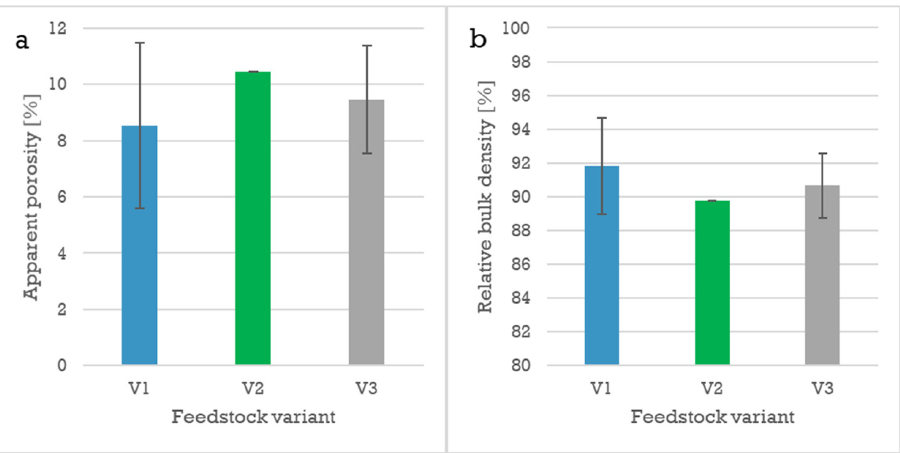
Figure 10. Apparent porosity ( a ), and relative bulk density ( b ) of the V1, V2, V3 sintered samples at 1550 °C for 120 min.